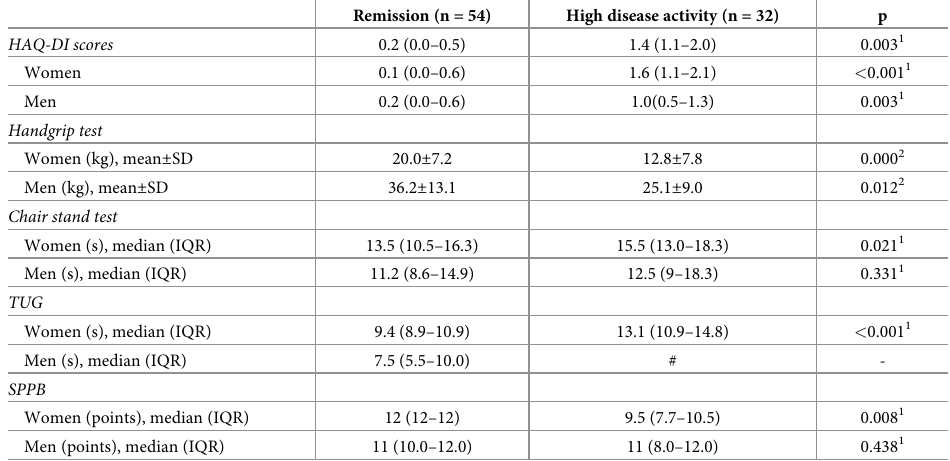
Table 3. Comparison of physical function, muscle strength and physical performance (disease remission versus high disease